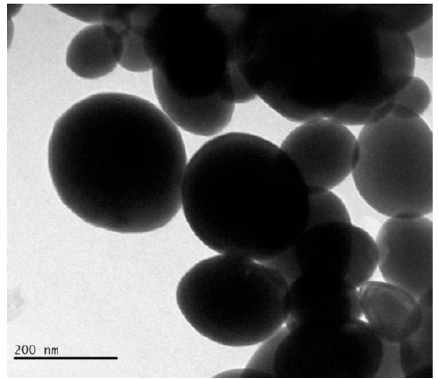
Figure 3. Transmission electronic microscopic capture of bismuth oxide nanoparticles with average diameter ranging from 150 nm to 200 nm. Picture is reprinted with permission from Abudayyak et al. [57] .